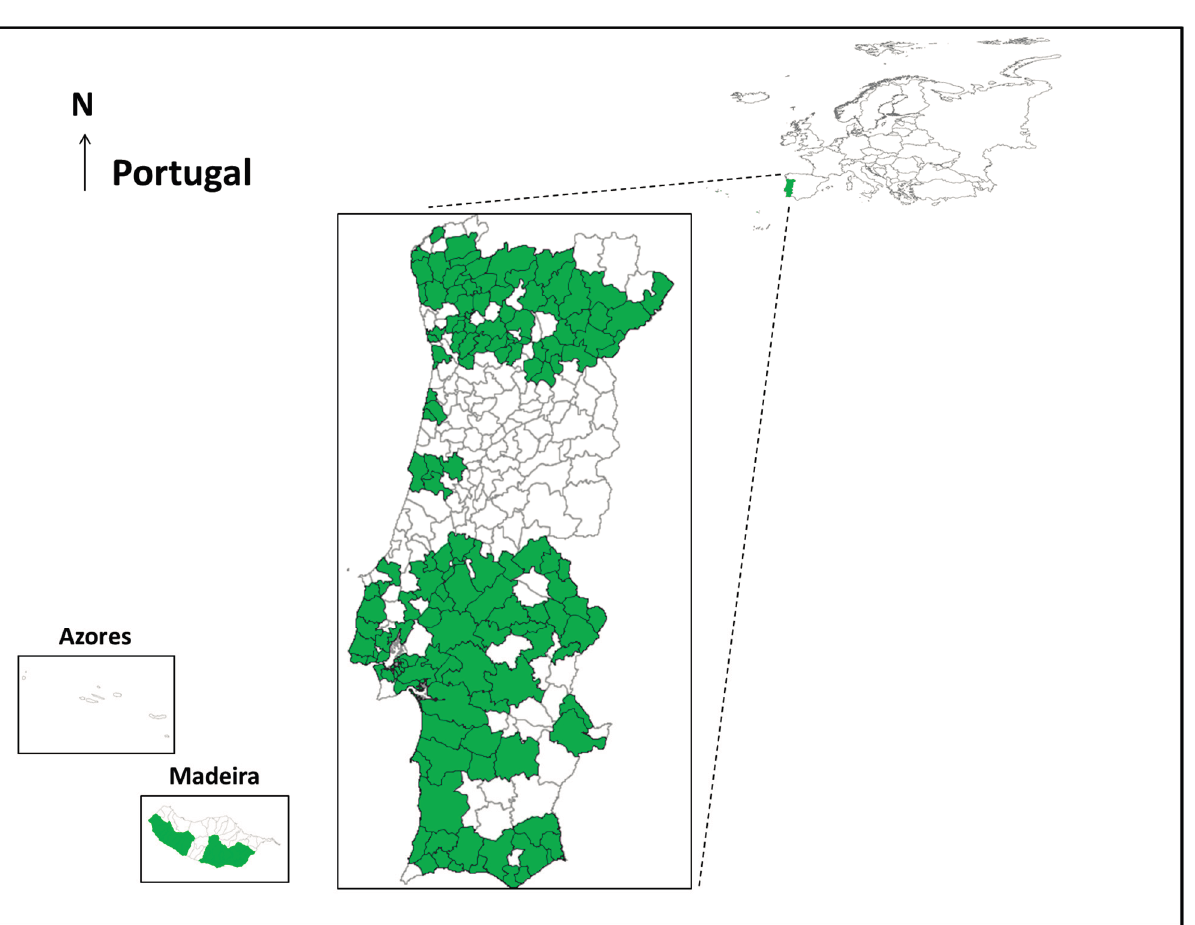
Figure 1. Geographic area under RE de de VI gilância de VE ctores (REVIVE); seven regions, 20 subregions and 151 counties (not to